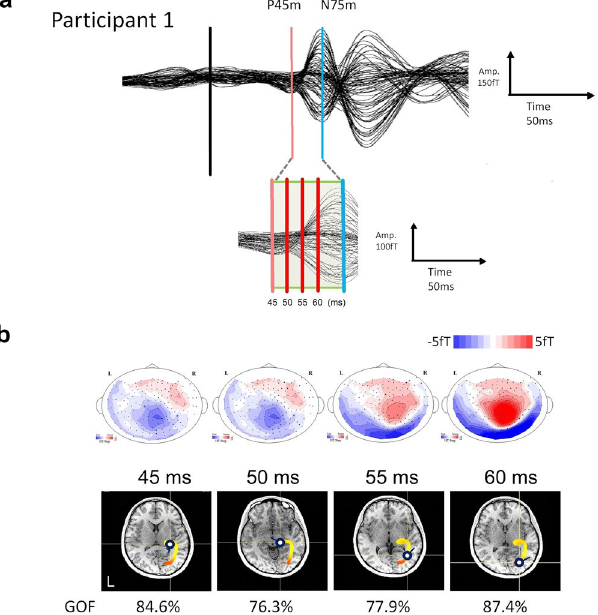
Figure 2. Representative visually evoked neuromagnetic fields following hemi-visual field light flash stimuli in a healthy volunteer. ( a ) Superimposed waveforms recorded from 80 locations of the right hemisphere depict the P45m and N75m deflections. Four points in the time sequence from 45 ms to 60 ms were analysed. ( b ) top , Estimated ECDs superimposed onto the horizontal plane of the participant’s MRI scan. Changes in the locations of the ECDs were calculated successively in 0.1-ms steps between 45 ms and 60 ms after the stimulus presentation. The C-shaped coloured curve shows the sequential changes in the ECD location from the LGN (light yellow) to the visual cortex (red). ( b ) bottom , Top view of the isocontour field distributions of the magnetic field over the head surface at 4 time points; red contours, magnetic source; blue contours, sink with a contour step of 5 fT for the latency of 45 ms to 60 ms. Note that the long distance between the maximum source and minimum sink and the wide intervals between any adjacent contour lines for the source or sink (45 ms and 50 ms) indicate deep current sources; by contrast, the short distance and narrow intervals between the adjacent contour lines (55 ms and 60 ms) indicate superficial current